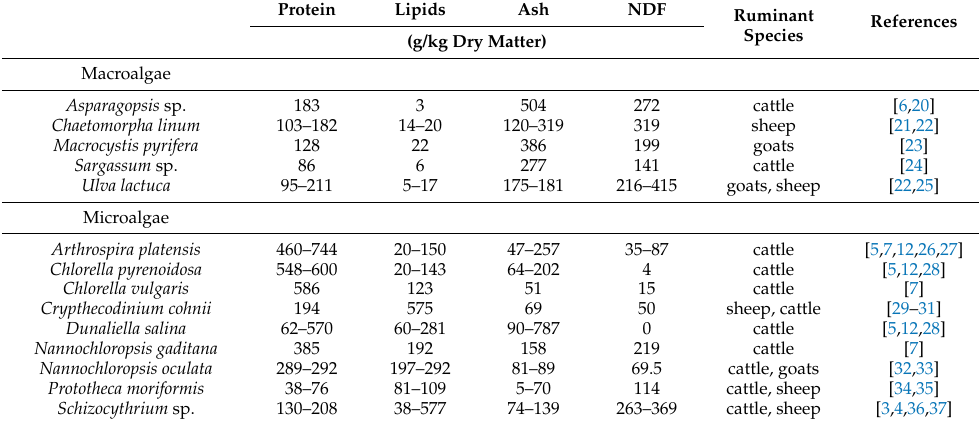
Table 1. Composition of macro and micro-algae species used for ruminants in their raw form. Protein